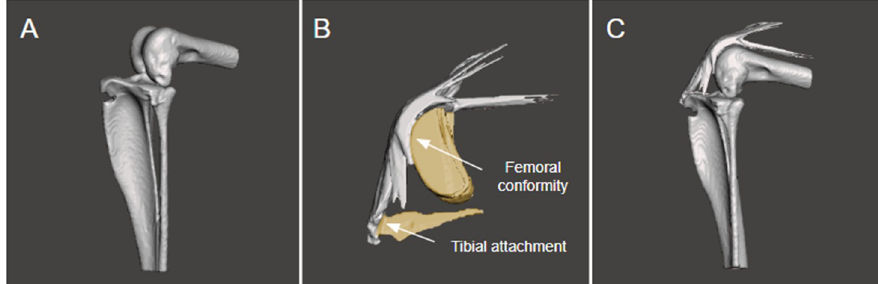
Figure 2. Three-dimensional models of the femur and tibia ( A ) were assembled with the knee extensor mechanism ( B ) using the femoral conformity and tibial attachment as a point of reference to generate the final model ( C ).